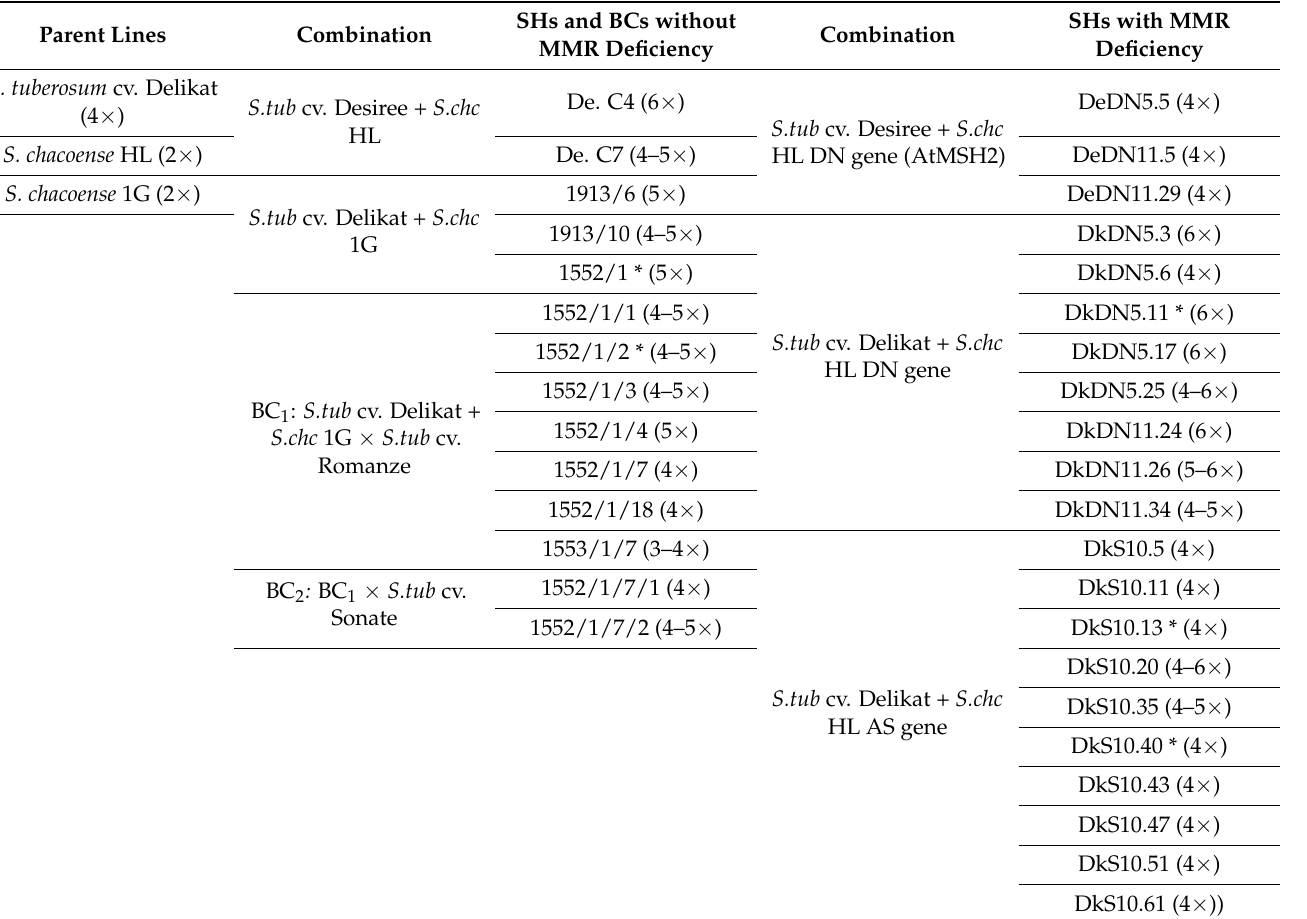
Table 2. Plant material used in the experiments: parents, somatic hybrids with or without MMR deficiency and derived backcrosses (BC 1 , BC 2